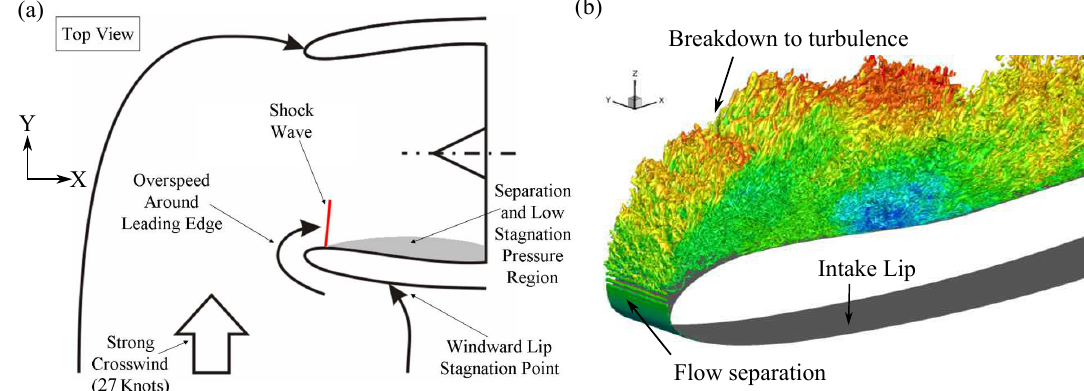
Figure 1. ( a ) Flow over an intake under crosswind [11]; ( b ) low-speed separation on intake lip (Vadlamani and Tucker